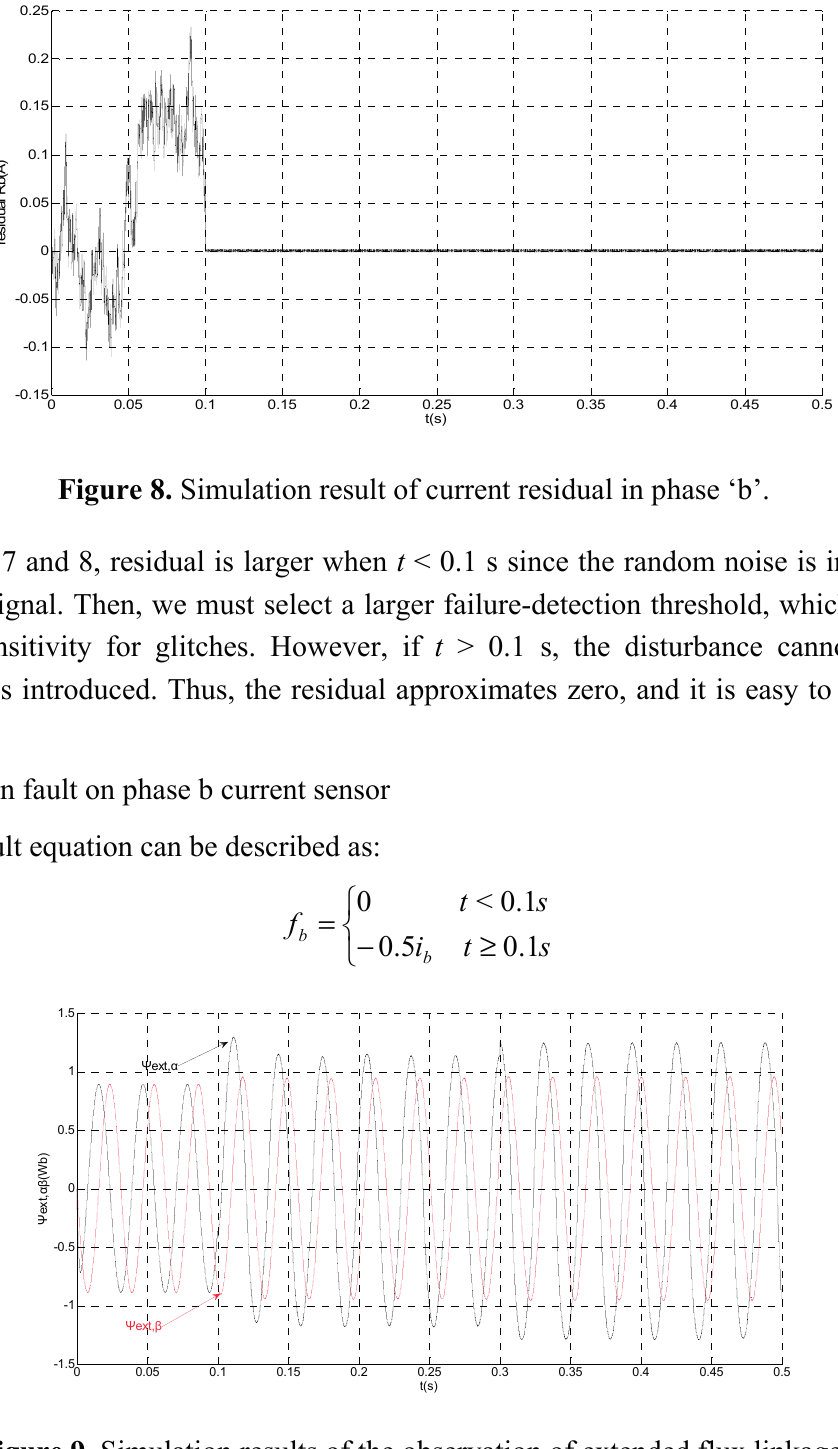
Figure 9. Simulation results of the observation of extended flux